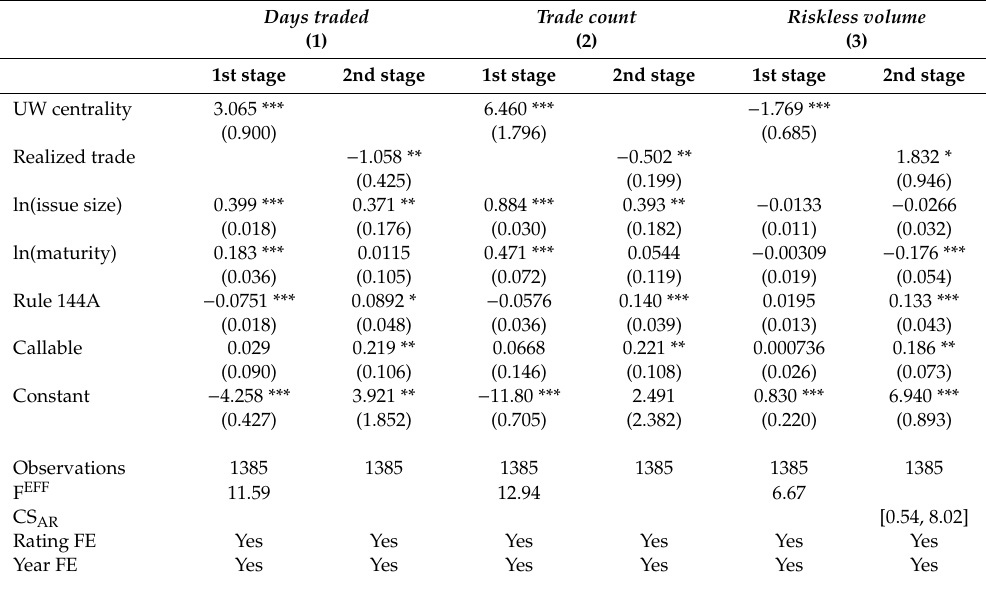
Table 6. IV Regressions for O ff ering Yield Spread: High Yield